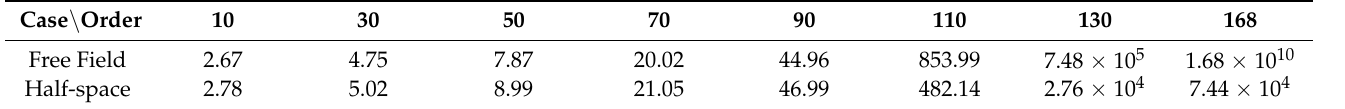
Figure 10. The variation of 𝛾 with the increase of ARM order when 135 uniformly arranged measurement points are used. Table 4. Different ARM truncation numbers in CMESM for 135 measurement